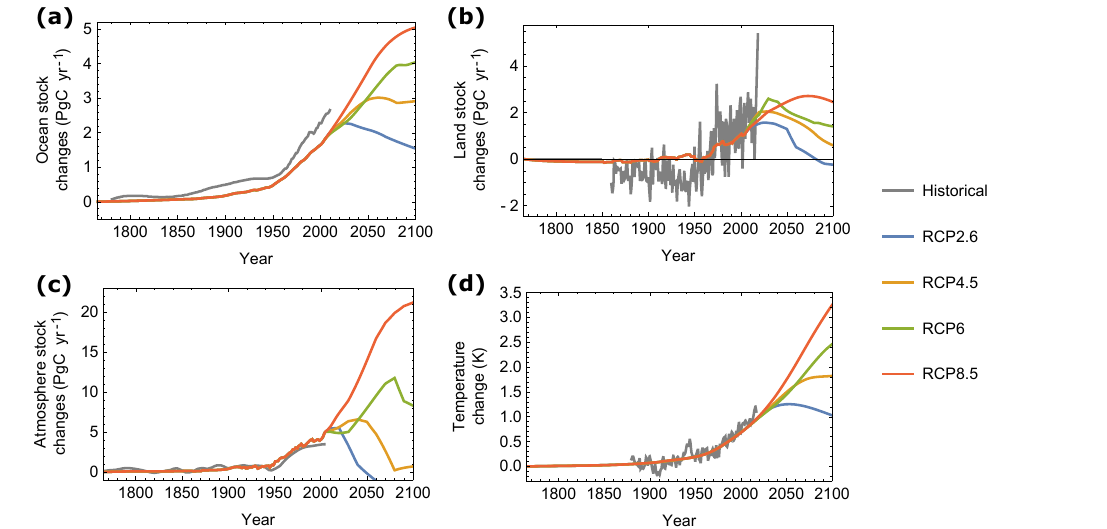
Figure 2. Model output under forcing from different RCP scenarios: (a) ocean carbon stock change, (b) land carbon stock changes, (c) atmo- spheric carbon stock change, and (d) global mean surface temperature change. Historical changes in carbon stocks are from Le Quéré et al. (2016) and historical temperature anomalies are from NOAA (2018). The historical temperature dataset of NOAA (2018), which is relative to the period 1901–2000, has been offset to match the model’s average temperature anomaly over the same